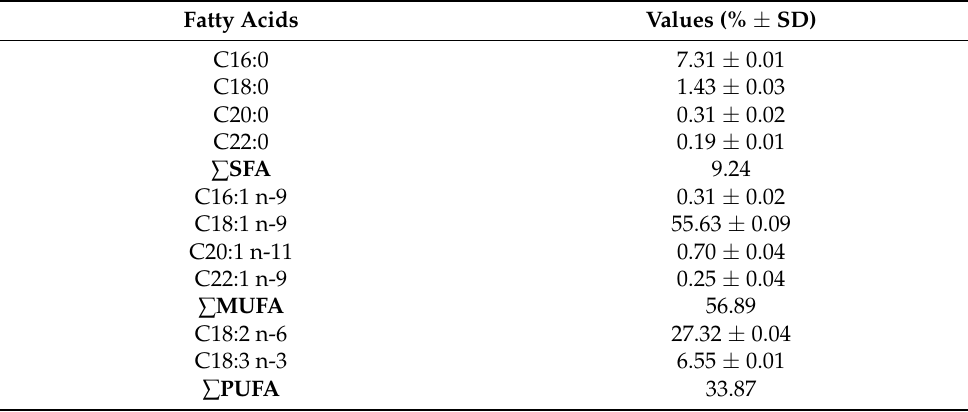
Table 1. Main fatty acid composition of rapeseed lecithin.